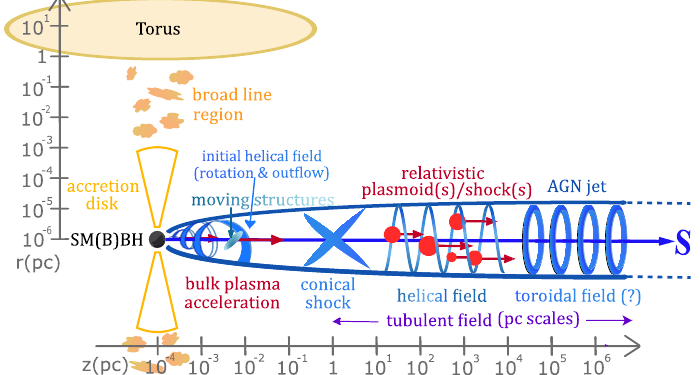
Figure 1. Structure of an active galactic nucleus (AGN) with a jet. Yellow/red components are targets for cosmic-ray interactions with gamma rays or gas. Blue colors indicate the likely structure of the magnetic field along the jet. Particle acceleration happens either at the shock fronts or in context with the relativistic